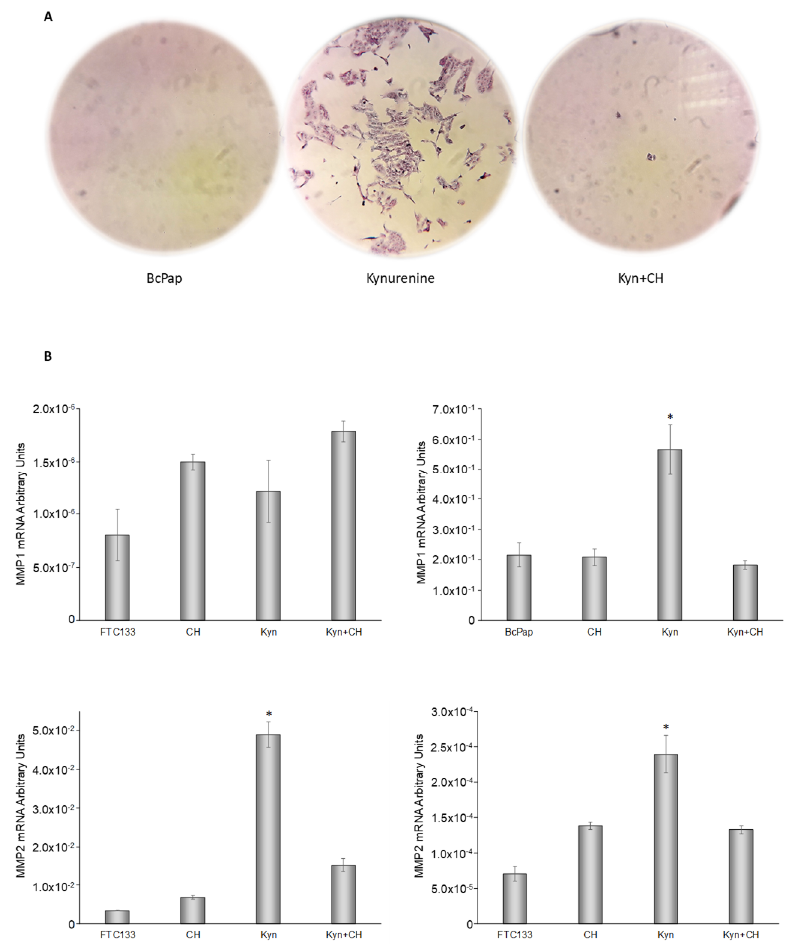
Figure 12. Kynurenine-induced AhR activation in tumor invasiveness. ( A ) Boyden chamber assay. FTC-133 and BcPap cells were seeded in a transwell in serum free medium. The bottom wells were filled with 10% FBS medium. Treatments were added to both chambers and renewed every 8 h. After 48 h, cells were fixed, stained with crystal violet and images were acquired using an optical microscope. Three independent experiments were performed and a representative one was shown. ( B ) FTC-133 and BcPAP cells were incubated for the indicated times with kynurenine (100 µ M) in the presence or absence of the AhR inhibitor CH223191 (10 µ M) and harvested for total RNA extraction and cDNA synthesis. MMP1 and MMP2 mRNA expression levels were assayed by qPCR. The data are presented as means of arbitrary units. All experiments were repeated three times and the more representative results are depicted. Kyn: kynurenine treated cells; CH: CH223191 treated cells. p values were calculated applying the unpaired Student’s t test. *, p < 0.05.